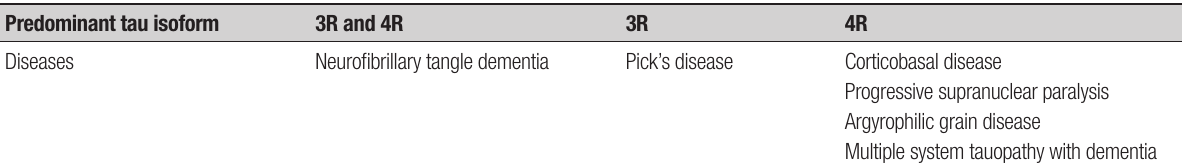
Table 1. FTLD-tau and tau